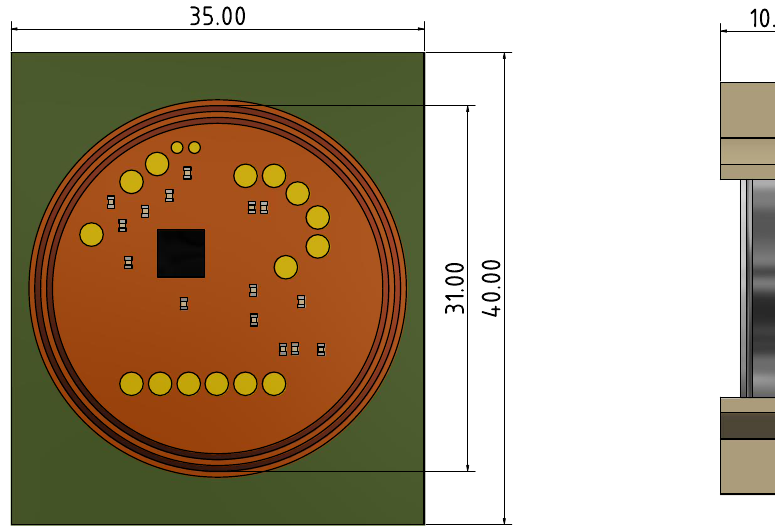
Figure 2. PCB cross section with